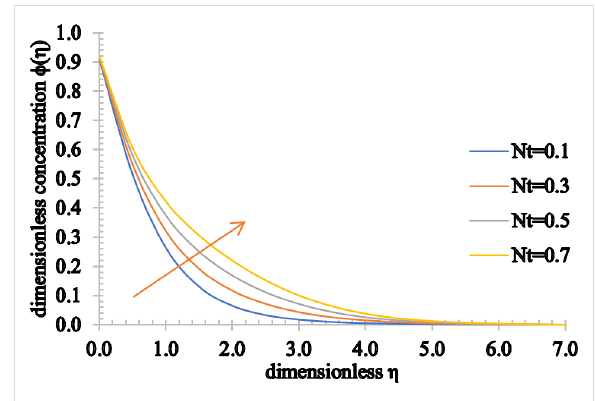
Figure 19: The concentration profile for increasing values of Nt